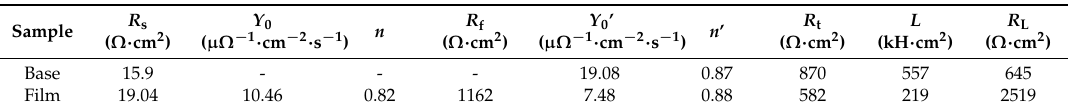
Figure 6. Equivalent circuits for the EIS spectra of: ( a ) the AM60 substrate and ( b ) the sample coated with film immersed in 0.6 M NaCl solution. Table 2. Fitting results of the EIS spectra for the AM60 alloy with and without film immersed in 0.6 M NaCl solution.